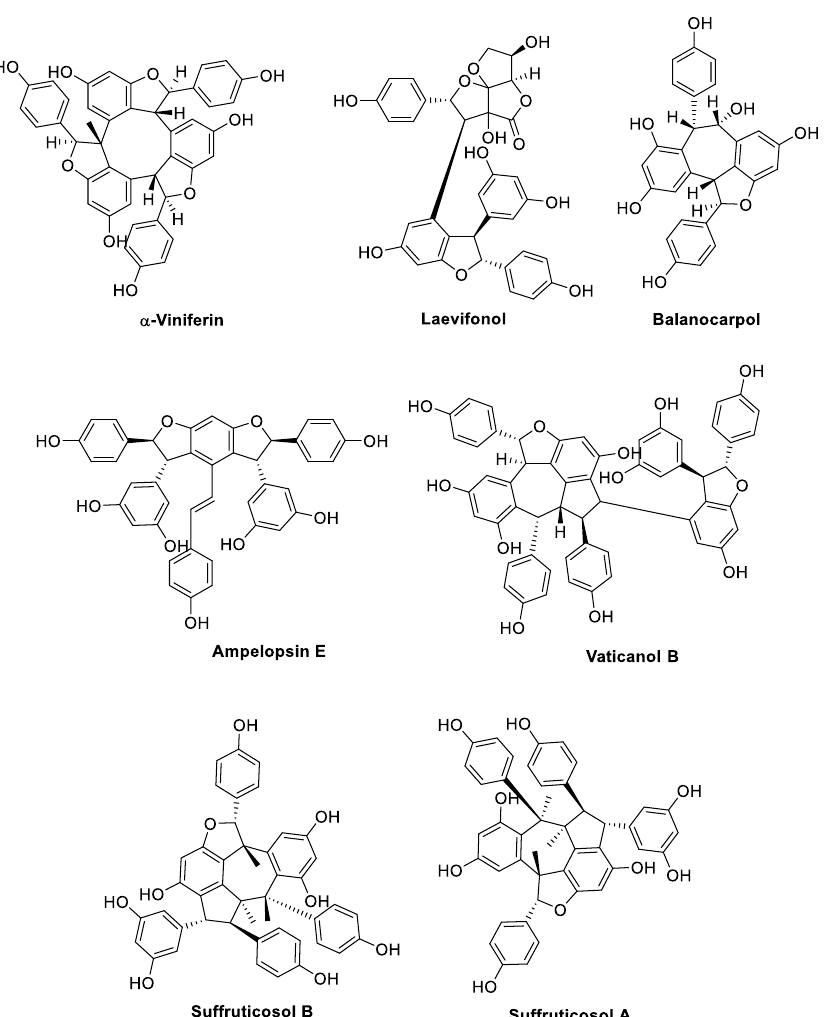
Figure 17. Structures of oligomeric stilbenoids from Shen et al. (2009) [32], Keylor et al. (2015) [100], and Sáez et al. (2018) [101].